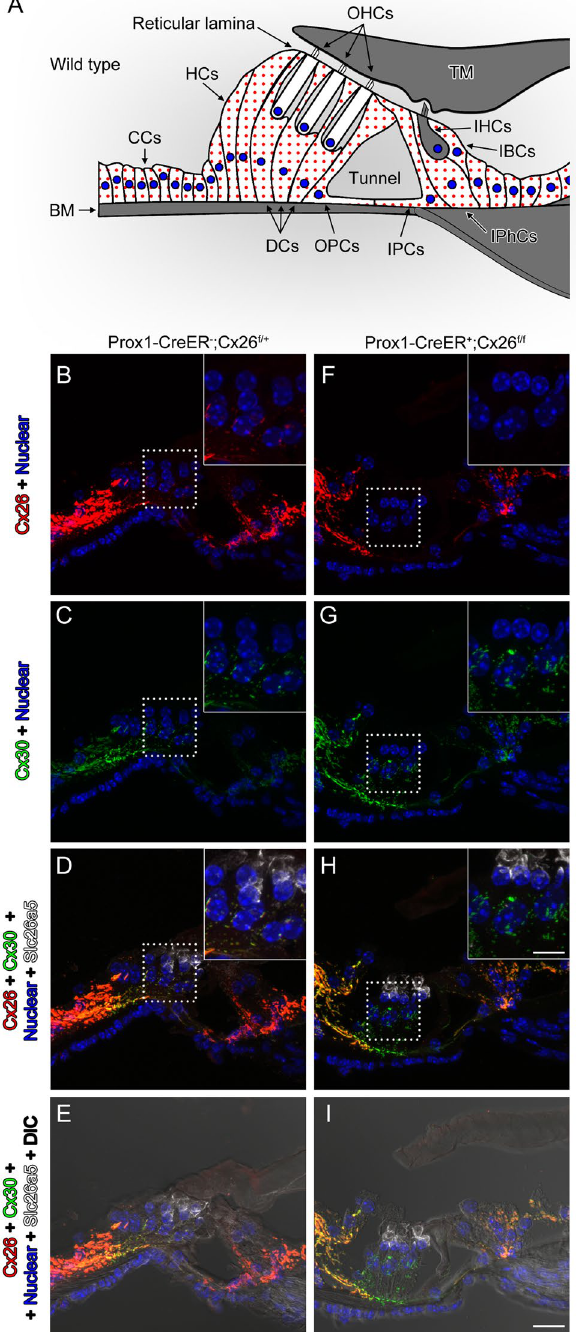
Figure 1. Specific deletion of Cx26 in Deiters’ and Pillar cells in Prox1-CreER; Cx26 f/f cKO cochleae. (A) Diagram of cross section of the organ of Corti. The cells containing red dots indicate Cx26 expressing cells in wildtype cochleae. Slc26a5 (prestin)-positive OHCs (by white) and the remaining regions (in grey) are indicated. DCs are located underneath of OHCs. IPCs and OPCs are located between IHCs and OHCs. (B – I) Cx26 (in red), Cx30 (in green), and slc26a5 (in white) expressions in middle turns of either wildtype (B – E) or Cx26 cKO cochleae (F – I) at P32 are shown. Counter-staining of nuclei is indicated in blue. Dashed boxes indicate the regions of the insets. Scale bar expresses 5 µ m (in I ) and 2.5 µ m (in an inset in H ). [See Fig. 2